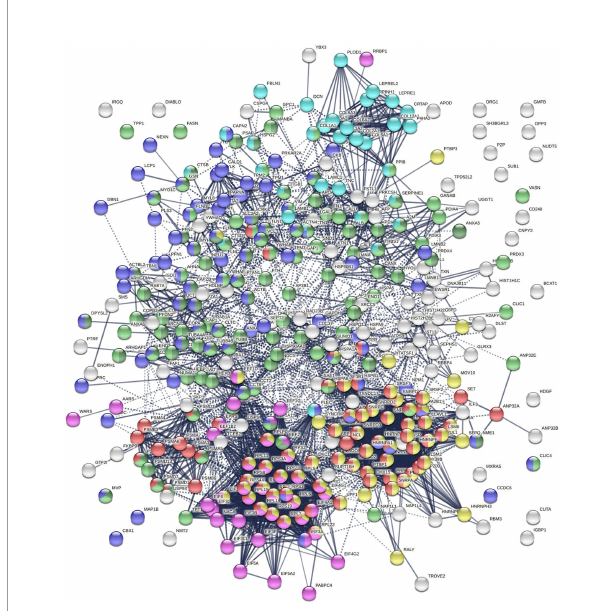
FIGURE 2 | Network of 352 autoantigen-ome proteins that are altered in SARS-CoV-2 infected cells or patients. Connecting lines represent interactions with high con fi dence. Colored proteins are involved in metabolism of RNA (77 proteins, red), mRNA metabolic process (69 proteins, gold), translation (43 proteins, pink), vesicles (99 proteins, light green) and vesicle- mediated transport (84 proteins, dark green), cytoskeleton (84 proteins, blue), and extracellular matrix organization (32 proteins,